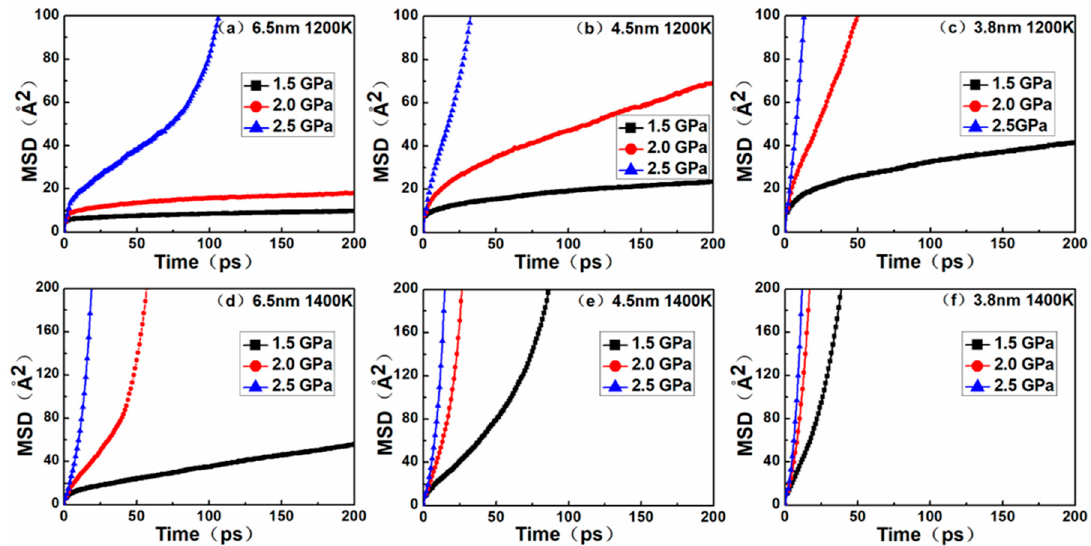
Figure 5. Plots of the MSD versus time for the nanocrystalline NiAl models with different grain sizes of ( a) 6.5 nm at 1200 K; ( b ) 4.5 nm at1200 K; ( c ) 3.8 nm at 1200 K; ( d ) 6.5 nm at 1400 K; ( e ) 4.5 nm at 1400 K; ( f ) 3.8 nm at 1400 K under the stress levels of 1.5, 2.0 and 2.5 GPa.